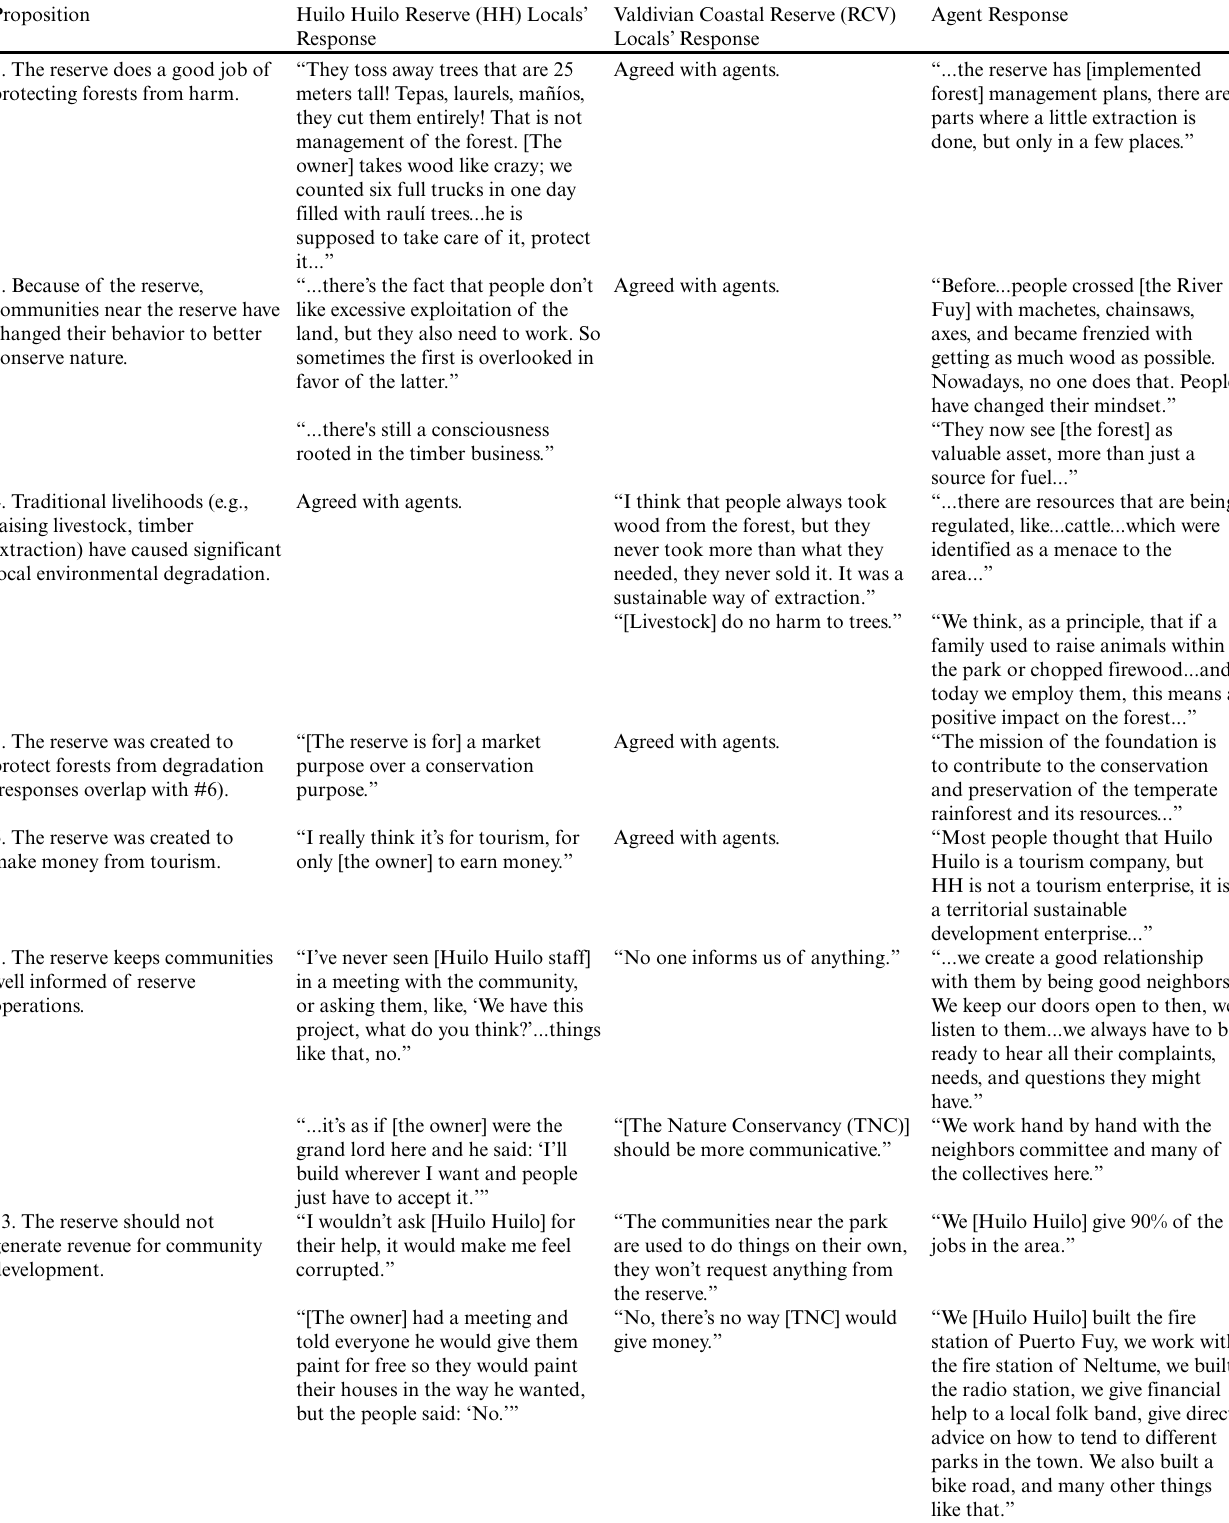
Table 3 . Contrasting views of locals and conservation agents about private protected area (PPA) propositions (hegemonic ideologies).